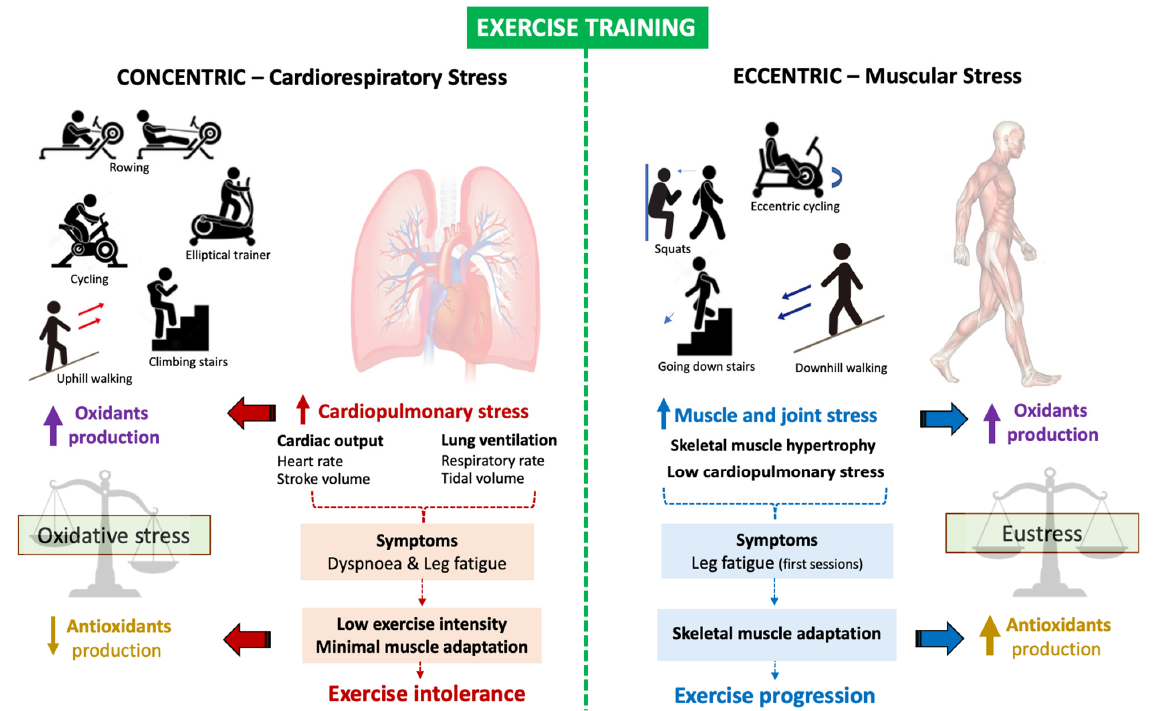
Figure 3. Overview of concentric and eccentric exercises (as the main components of the movement) on the cardiopulmonary and muscle systems, symptoms associated with these exercises, and their effects on redox balance.